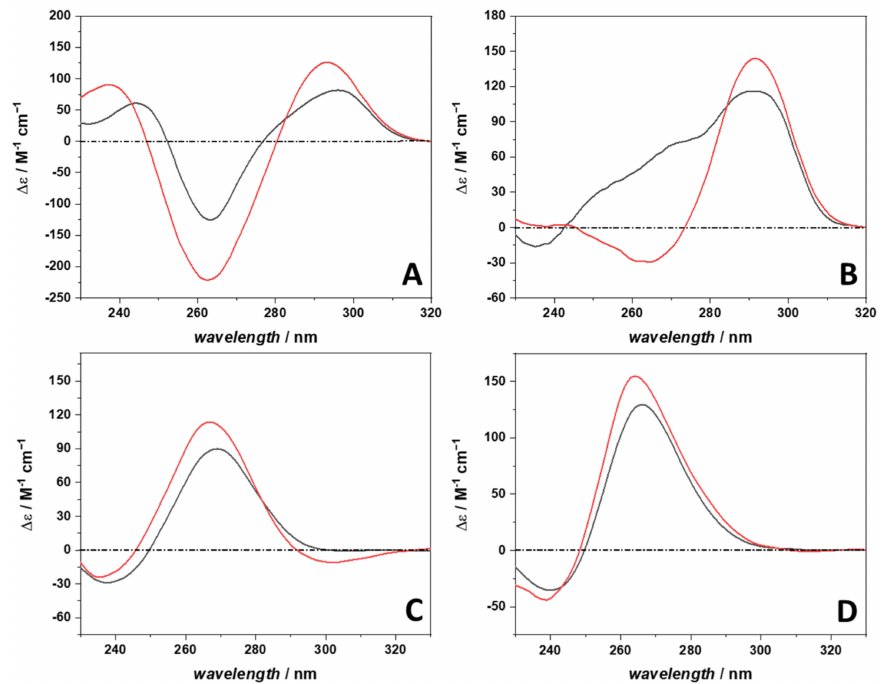
Figure 6. Circular dichroism (CD) spectra of the 22AG quadruplex in the absence (black spectra) and in the presence (red spectra) of berberine (22AG:Berb = 1:10) in ( A ) 30 mM Tris, 100 mM NaCl, pH 7.4, and ( B ) 30 mM Tris, 100 mM KCl, pH 7.4. In the bottom panels, the CD spectra for the RG-1 sequence in the absence (black spectra) and in the presence (red spectra) of berberine (22AG:Berb = 1:10) are reported for the measurements carried out in ( C ) 30 mM Tris, 100 mM NaCl, pH 7.4, and ( D ) 30 mM Tris, 100 mM KCl, pH 7.4. The path length of the cuvette was 0.1 cm. The temperature was set to 25 ◦